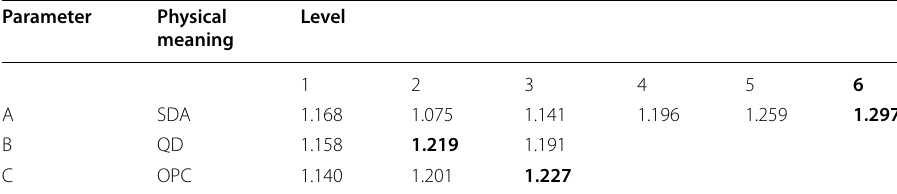
Table 10 Parameter effect on the mean cross-efficiency scores